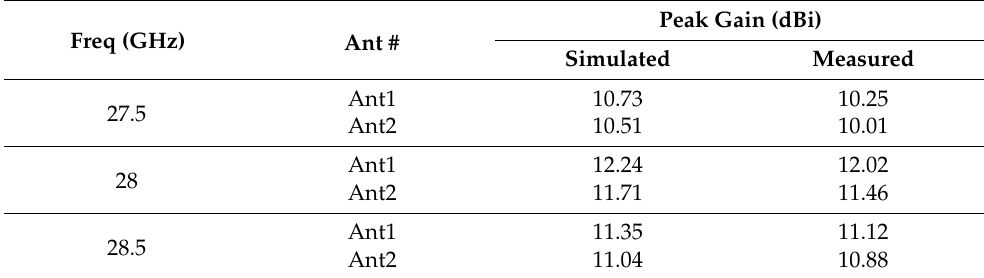
Figure 12. 3D Radiation Patterns at 28 GHz. ( a ) Ant1; ( b ) Ant2. Table 2. Simulated and measured gain of the MIMO antenna elements. Table 2. Simulated and measured gain of the MIMO antenna elements.